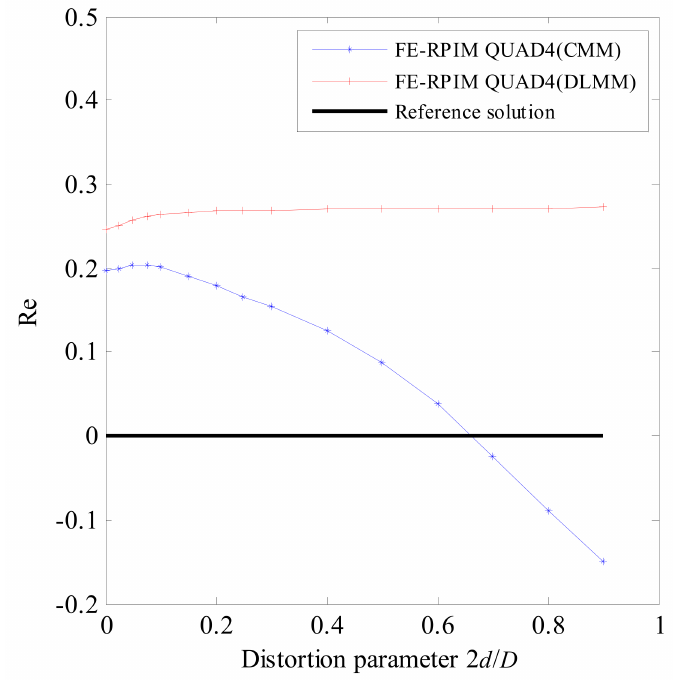
Figure 15. Comparison of accuracy of FE − RPIM QUAD4 (CMM) and FE − RPIM QUAD4(DLMM) for mesh distortion sensitivity test.